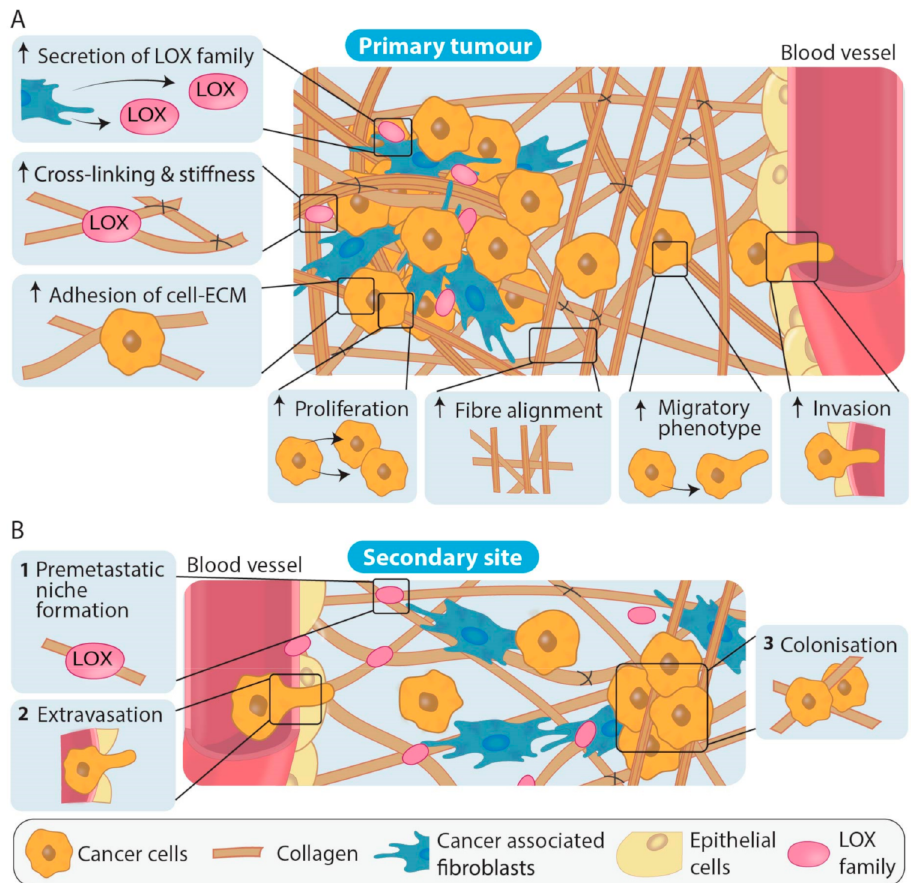
Figure 4. LOX family involvement in primary tumour formation and during the establishment of metastases. ( A ) Increased LOX cross-linking at the primary tumour site increases collagen fiber alignment as well as inducing multiple signaling cascades that result in the increased adhesion of cells to the ECM, increases in cancer cell proliferation, migration and invasion. Overall, LOX family actions result in changes in density and stiffness of the ECM that promote cancer cell dissemination to secondary sites. ( B ) At secondary sites, LOX family members are involved in generating a collagen rich ECM (1) and premetastatic niche formation through collagen remodeling (2). Extravasation of cancer cells to the premetastatic site and colonization of the cancer cells resulting in metastases (3) can then